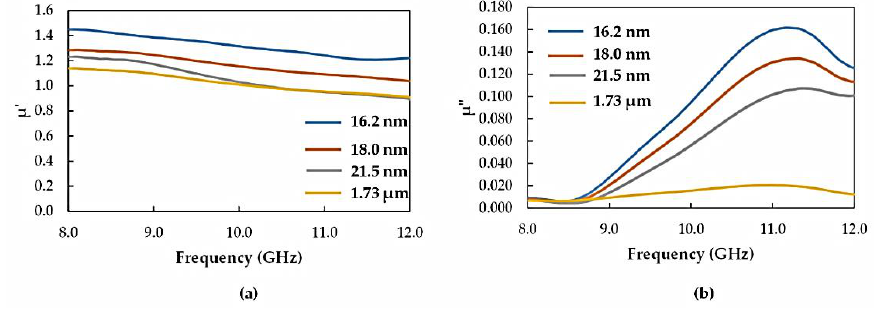
Figure 10. Variation of ( a ) μ' and ( b ) μ" with frequency for the recycled α -Fe 2 O 3 particles.